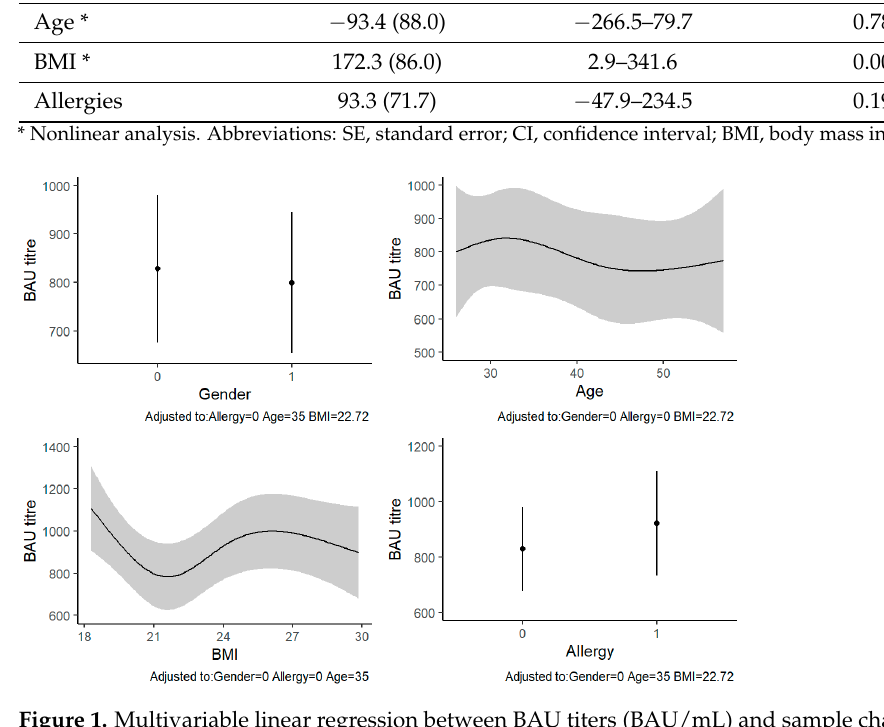
Figure 1. Multivariable linear regression between BAU titers (BAU/mL) and sample characteristics: The four plots report the predicted values of BAU titer for each model’s covariates, adjusted for the other variables. Abbreviations: BAU, binding antibody units; BMI, body mass index.